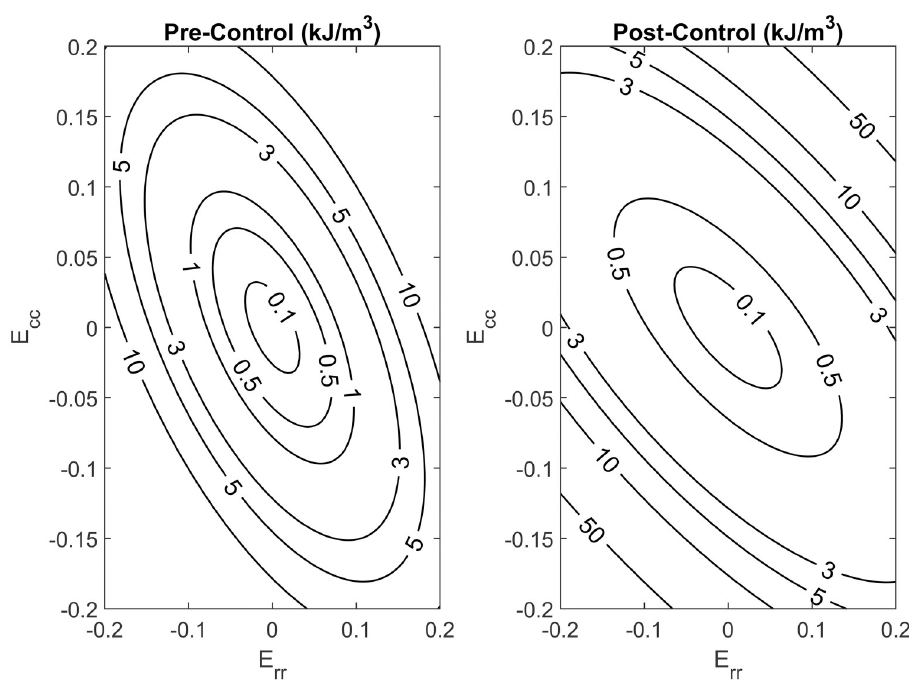
Fig 7. Strain energy density contours, generated before and after PBS treatment, for a typical heart in the control group.